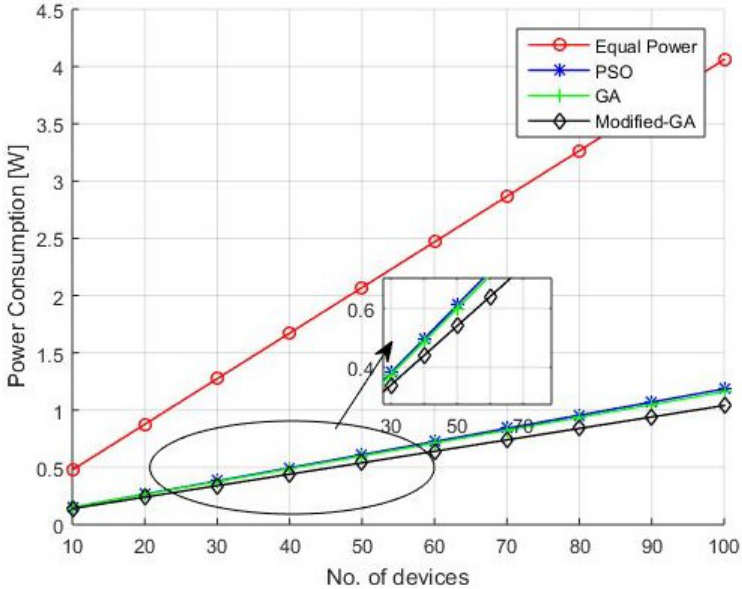
Figure 10. Power consumption vs. number of users for different optimization techniques.